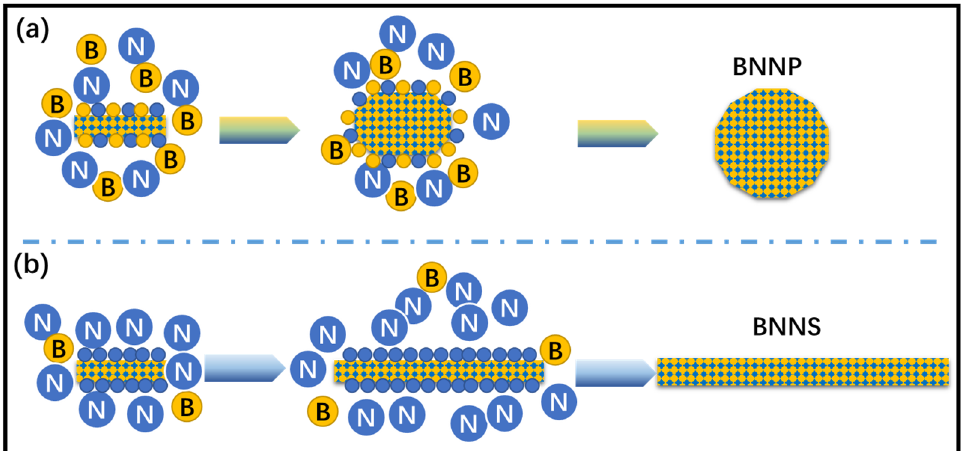
Figure 3. Proposed formation mechanism and schematic illustration of the e ff ect of molar ratio of